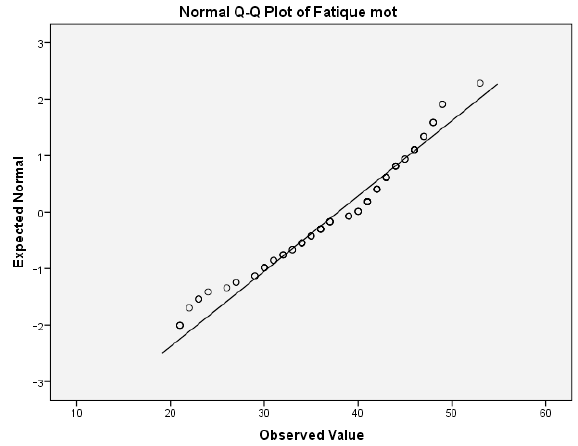
Figure 6. Normal Q-Q plot of motor fatigue.